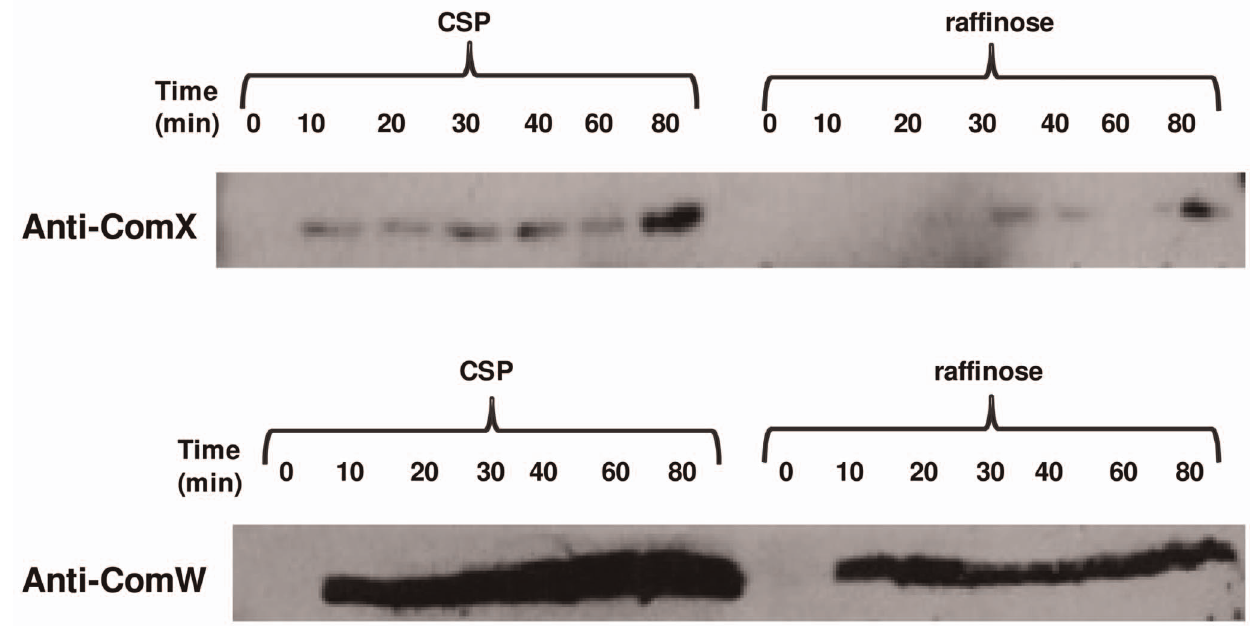
Figure 8. Reduced levels of ComX and ComW under ectopic regulation of competence. Late gene expression was induced in strain CP1932 ( aga::comX::comW , ssbB::lacZ, D clpC, D clpE ) by 250 ng/ml CSP or 0.1% raffinose respectively at OD 0.1. The cultures were sampled at 0, 10, 20, 30, 40, 60, and 80 min after induction for western blotting assay. Two SDS-PAGE gels were run in parallel and probed with different antibodies: Top, PVDF membrane probed with anti-ComX antibody; Bottom, PVDF membrane probed with anti-ComW